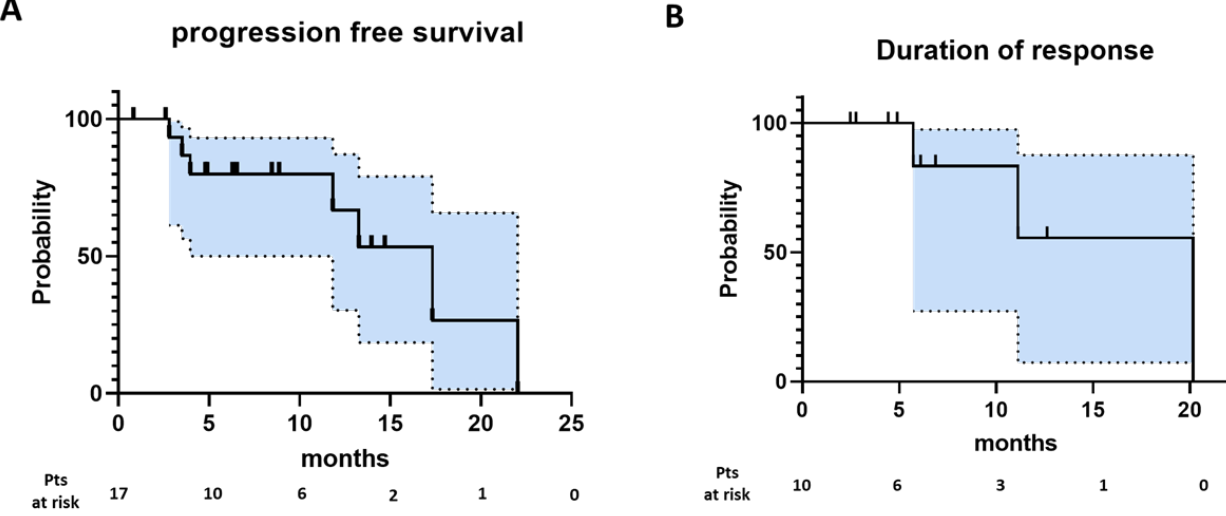
Figure 1. Kaplan–Meier curve for progression-free survival ( A , n = 17) and duration of response ( B , n = 10) are shown.